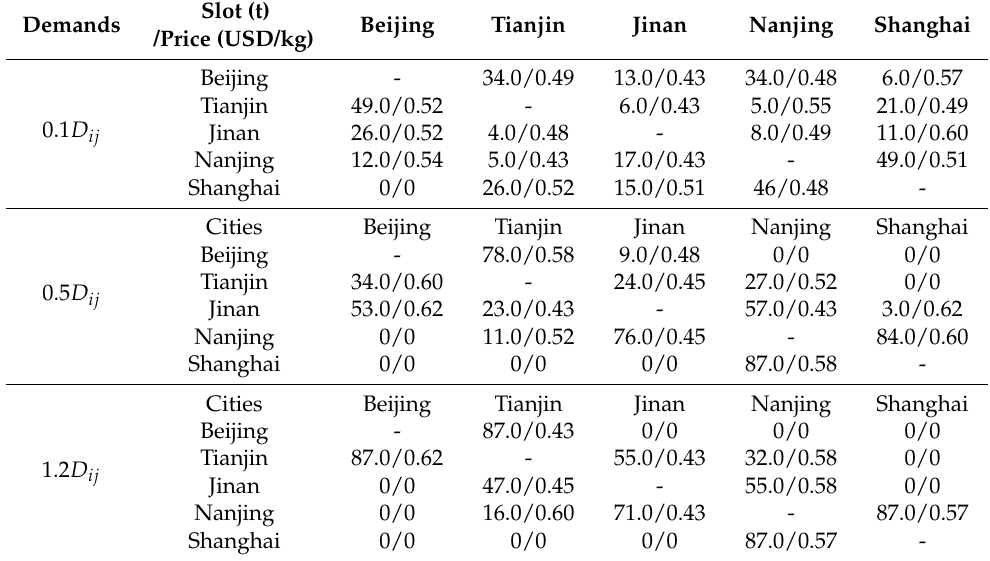
Table 5. Optimal combination scheme under different